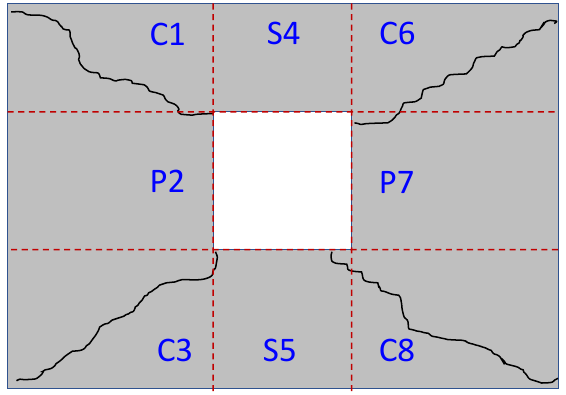
Figure 14. The discretization of the damaged wall specimen by Kalali and Kabir [34]. In order to analyze this wall with the proposed method, first, it is divided into macro- panels of 3 × 3 mesh size, including eight solid panels and one void panel for the opening. This means a total of 48 stress parameters are introduced at 16 nodes. In order to satisfy the equilibrium for eight rectangular panels, 16 equilibrium equations are obtained by using Equations (1), (2) and (7). For ensuring the boundary conditions, six normal force and six shear force equations are obtained. In addition to that, one equilibrium condition for vertical external force is provided at the top surface. Furthermore, two boundary conditions are obtained for the window opening. For 16 nodes, 16 Mohr–Coulomb points are considered according to the reported damage state of the specimen after experiment, and therefore, 16 equations are procured. At the end, for the 48 unknowns, 48 equations are obtained and solved by the written Matlab code. The maximum lateral load Q is obtained as 28.13 kN as a result of the numerical computation. The maximum lateral load obtained from the experiment is 26.1 kN. It can be seen that the lateral capacity values obtained from the experiment and the proposed approach are very close to each other. The error percentage of 8% indicates that the analysis result is consistent with the physical behavior obtained through